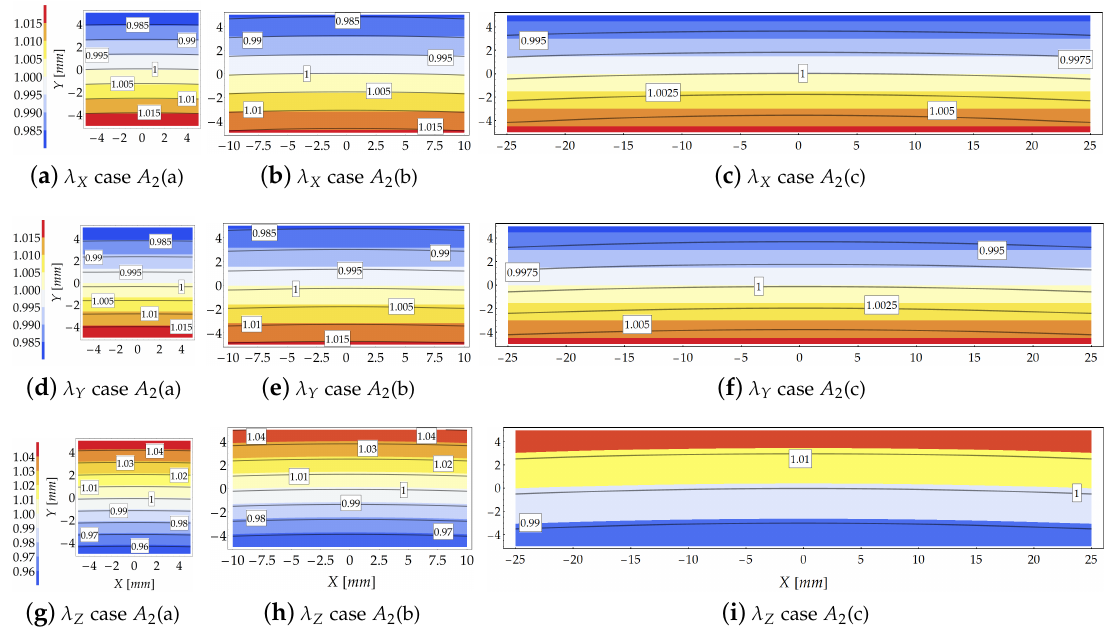
Table 4. Study case A 2 : Relative error on the shear resultant (cid:101) r , F β 2 / β ES and weight of the fifth-order truncated term ρ 20 + ρ 2 β 2 C Load Subcases Mult.